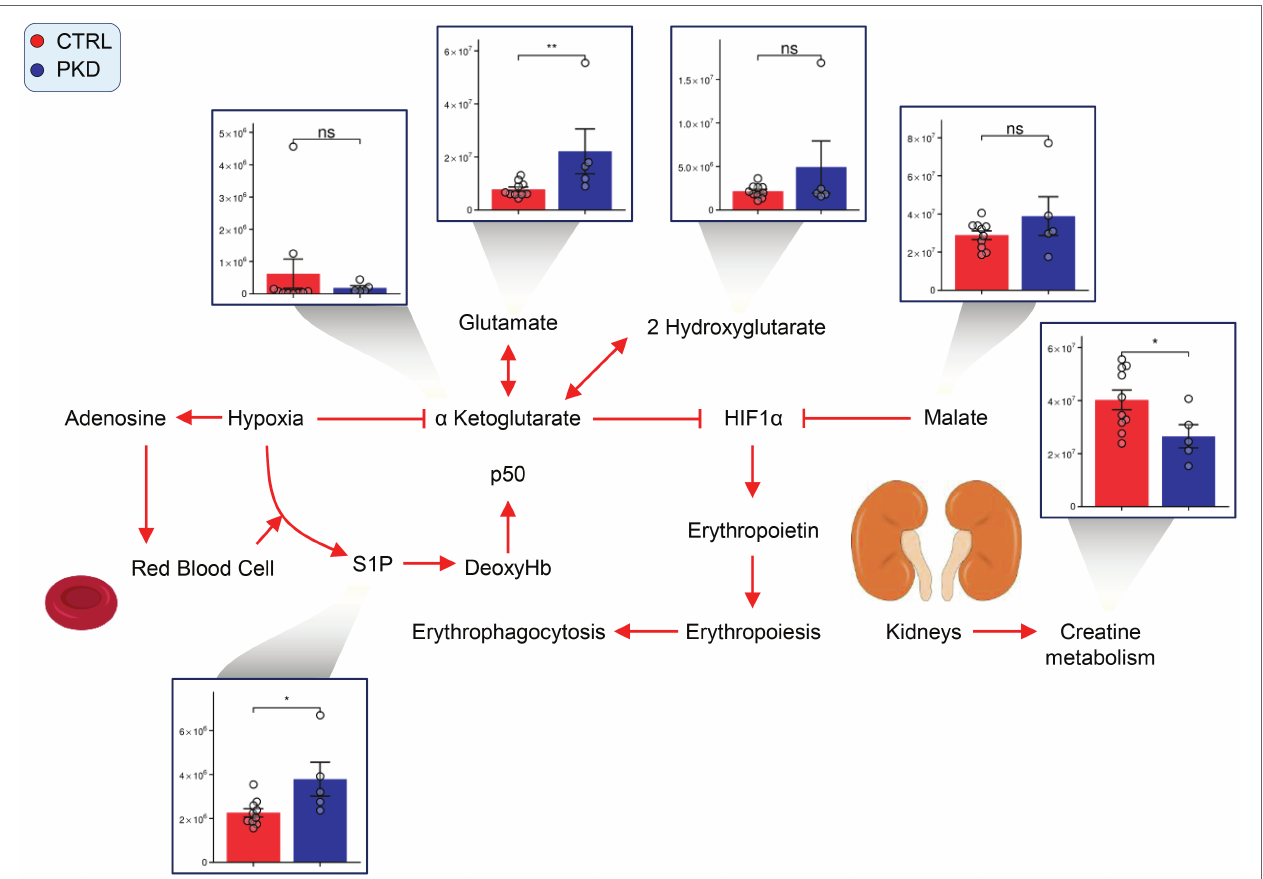
FIGURE 6 | Pyruvate kinase deficiency induces a hypoxic response in red cells. Overview of hypoxia induced signaling pathways in PKD red cells. Y-axes represent peak area (arbitrary units). Asterisks indicate significant results, error bars represent ±SEM (unpaired t -test, two-tailed distribution, * p < 0.05, ** p < 0.01, and *** p <